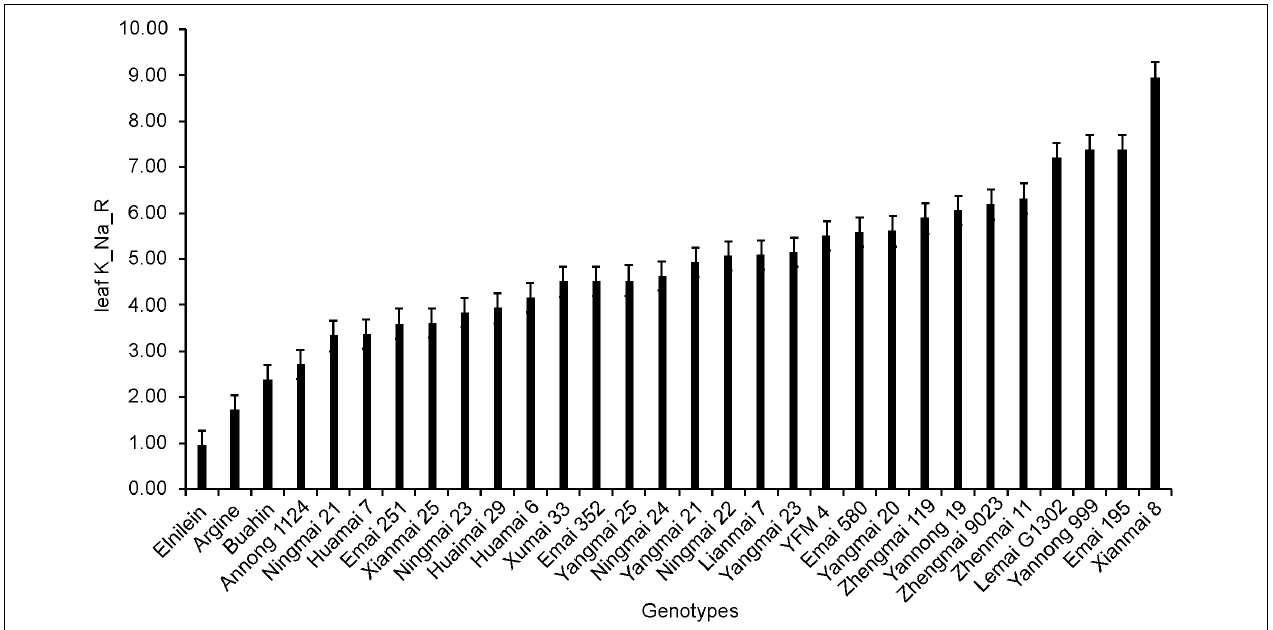
FIGURE 3 | Leaf K + /Na + ratio of 30 wheat varieties under 150 mM NaCl stress.